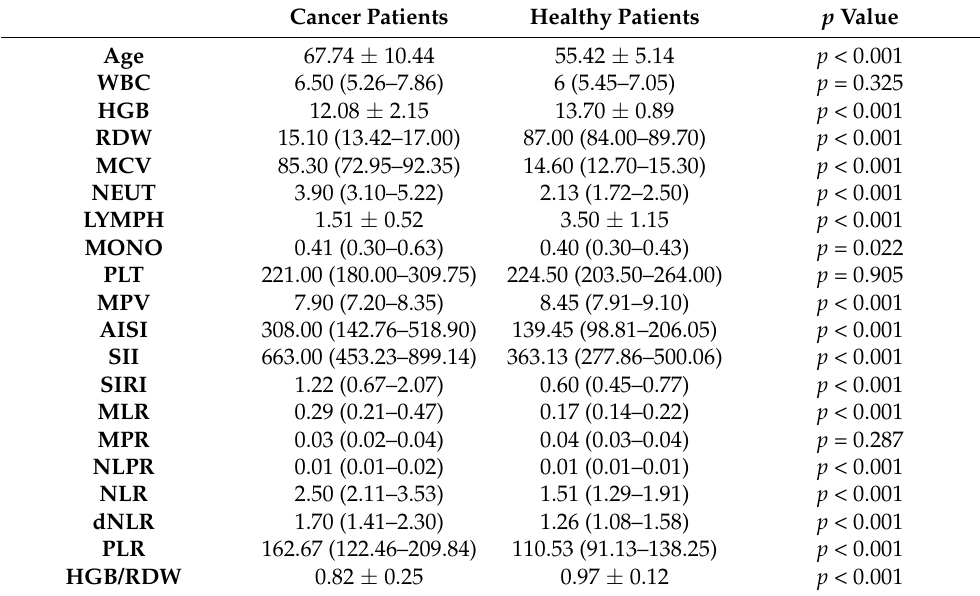
Table 1. Clinical and biochemical parameters between patients with colorectal carcinoma and healthy